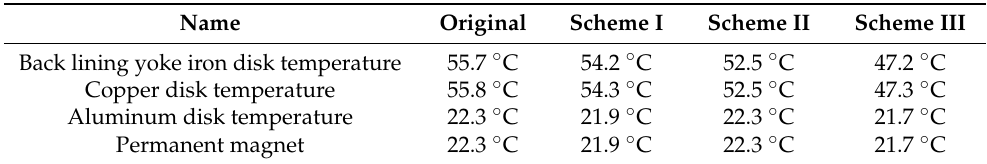
Table 3. Comparison of